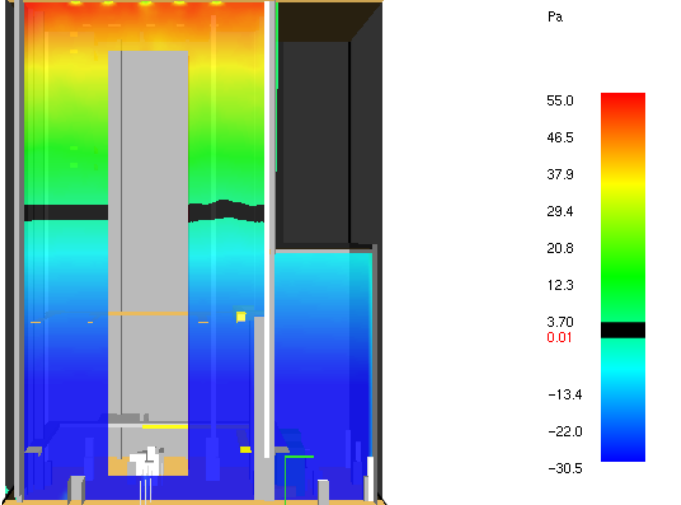
Figure 5. Position of the neutral plane and pressure distribution in the boiler house in the event of a fire, with the effective ventilation surface of 50 m 2 .